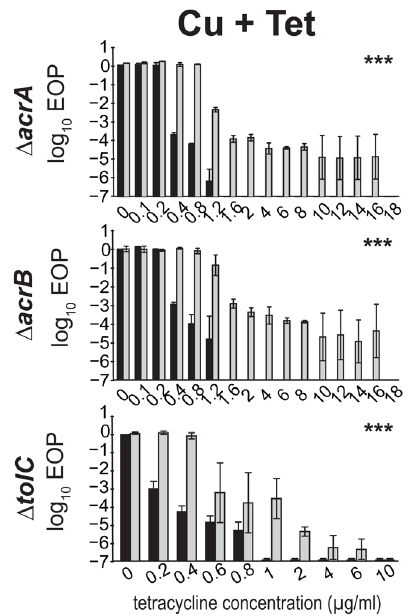
Figure 3. Change in EoP when E. coli deletion strains are (grey) and are not (black) exposed to Cu in the presence of Tetracycline. The x-axis indicates antibiotic concentration in µg/mL. Copper was added at 450 µg/mL. Error bars are standard errors (SEM, with SEM=standard deviation/ √ n). Asterisks indicate P values for interaction terms (see Materials and Methods). * P <0.05; ** P <0.01; *** P <0.001; ns, not